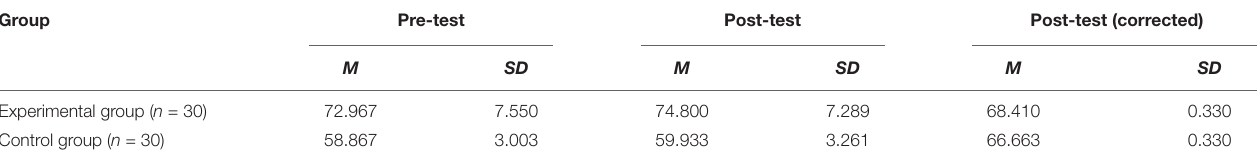
TABLE 6 | Description of the participants in the pre-test and post-test of the oral proficiency.